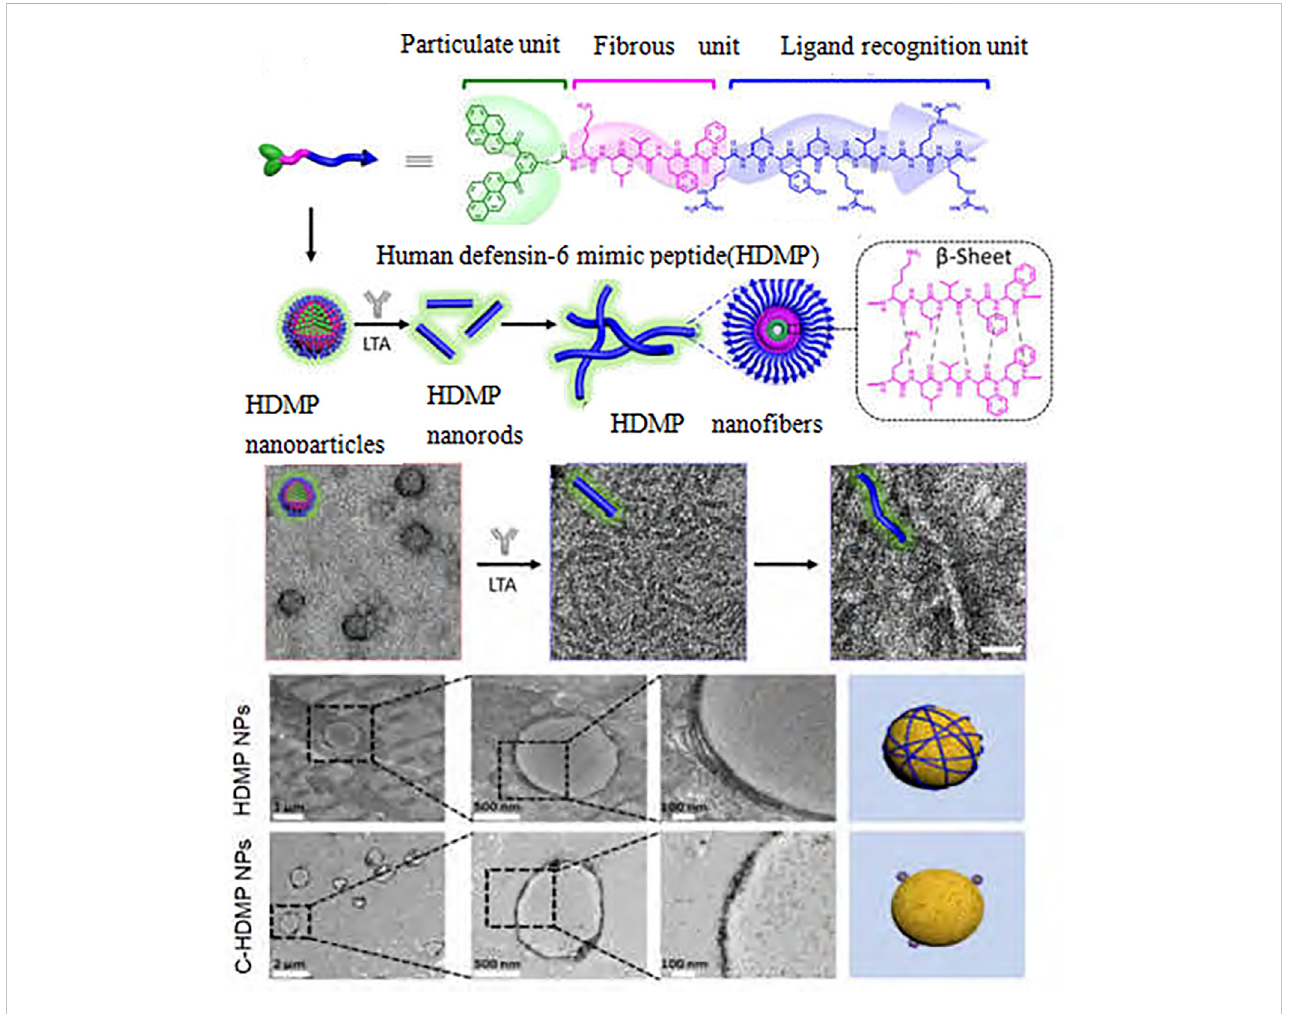
FIGURE 3 HDMP for antibacterial